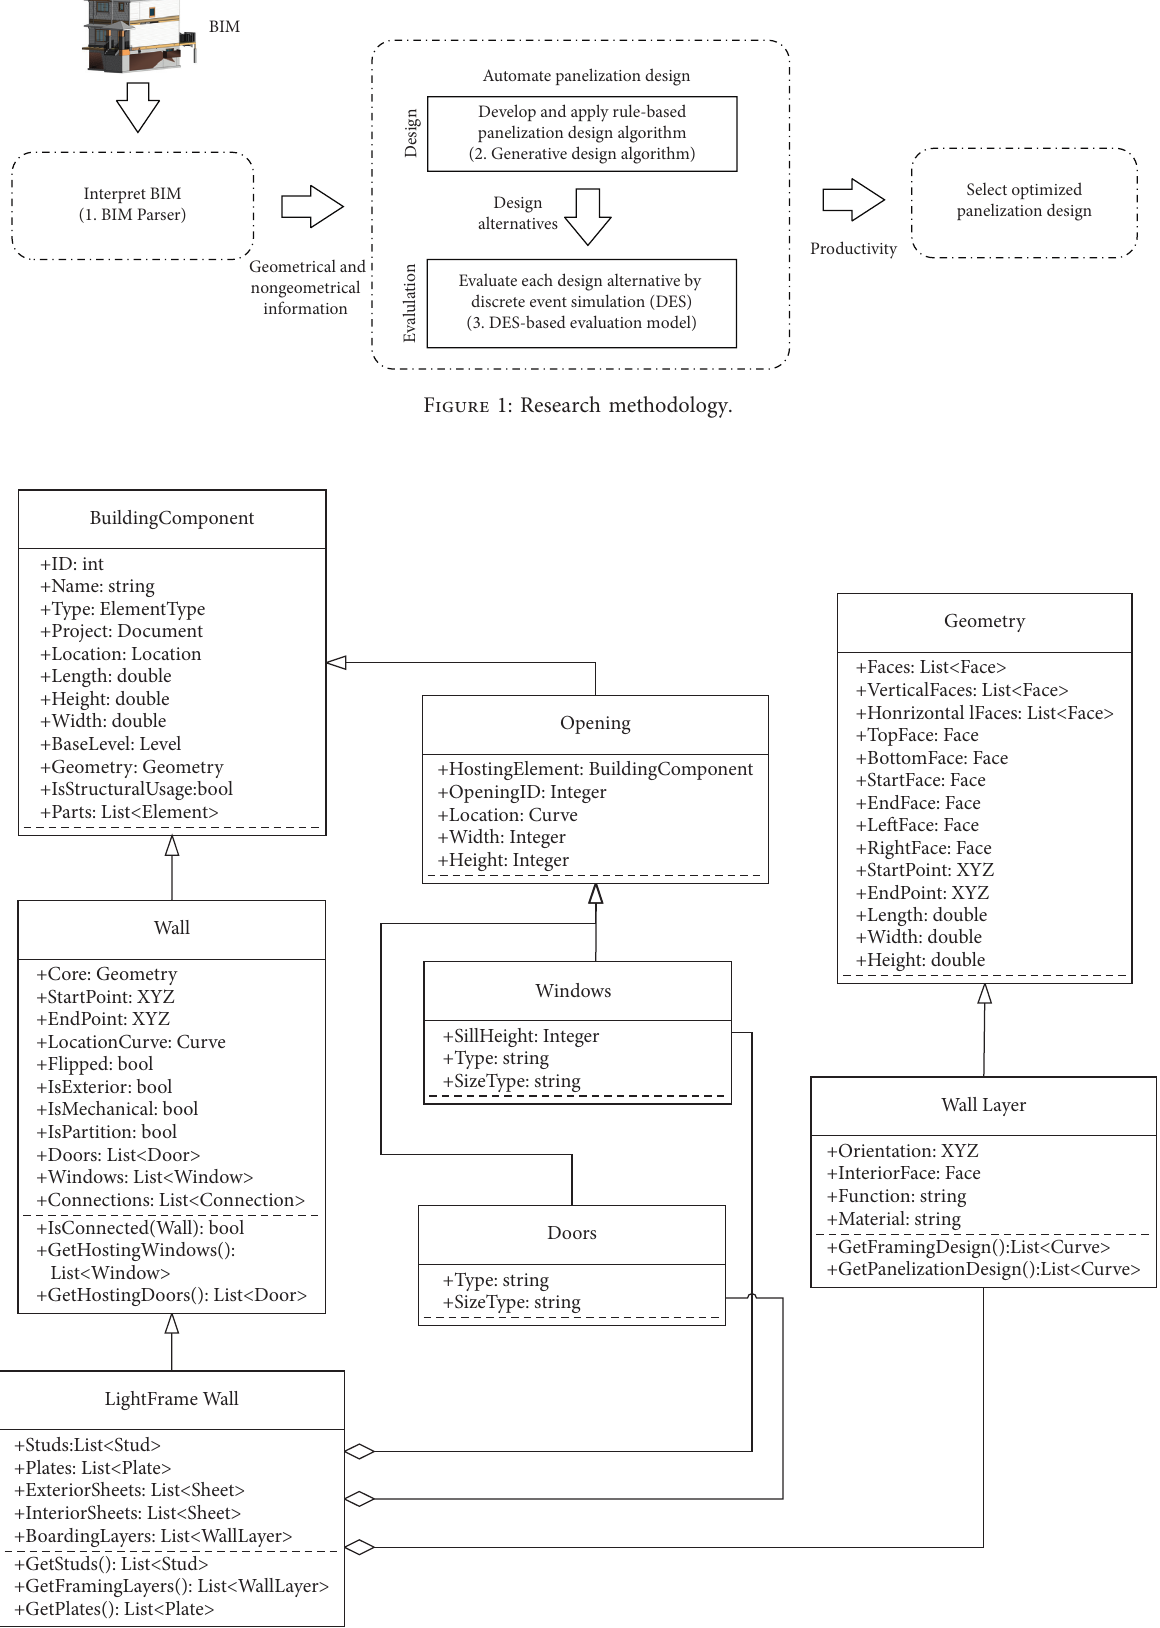
Figure 2: Building information for panelization design.